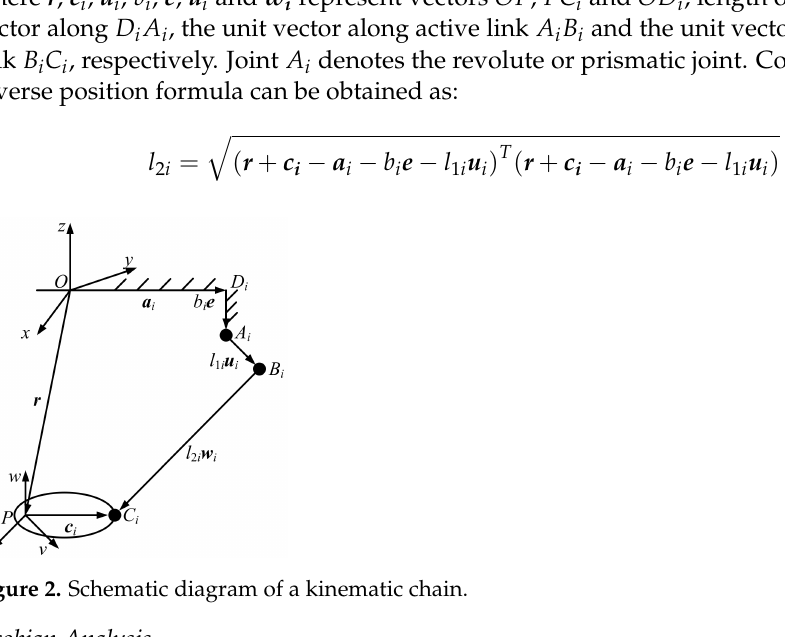
Figure 2. Schematic diagram of a kinematic chain.